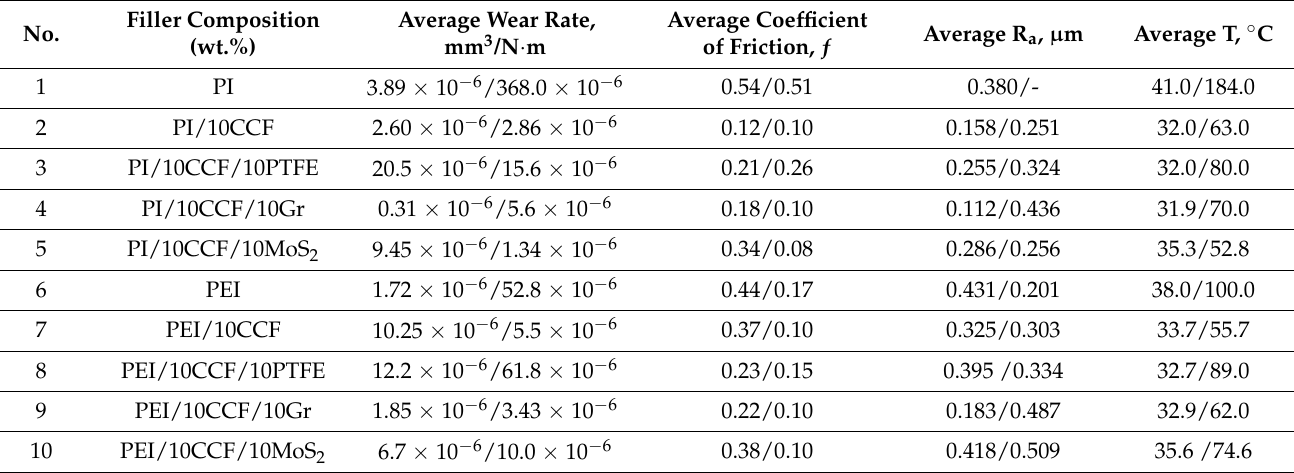
Table 2. The ceramic-polymer tribological contact under the ‘mild’/‘severe’ conditions (“ P = 60 N, V = 0.1 m/s”/“ P = 180 N, V = 0.5